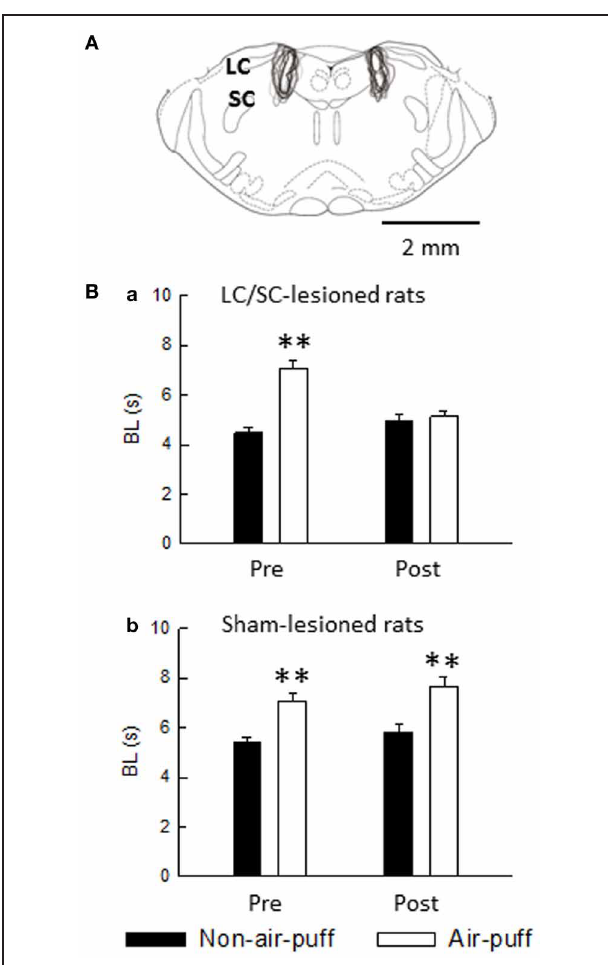
FIGURE 11 | (A) Extent of neurotoxin-induced bilateral lesions of the LC/SC ( n = 10). The rostrocaudal extension was between 0.8 and 1.5mm, and the LC/SC was always completely destroyed ventrodorsally throughout its rostrocaudal extension. The drawing is simplified from Paxinos and Watson (1998). (B) The effect of either bilateral lesions of the LC/SC ( a , n = 10) or sham lesions of the LC/SC ( b , n = 10) on the bite latency. Pre, pre-lesions; Post, post-lesions. ∗∗ P < 0 . 01, significantly different from bite latencies of the non-air-puff condition. Note that a significant air-puff stimulation-induced prolongation of the bite latency was not observed in post-lesions of the LC/SC-lesioned rats, whereas bite latencies were significantly prolonged by air-puff stimulation in pre-lesions, suggesting that the LC/SC is involved in air-puff stimulation-induced nociceptive modulation (Tsuruoka et al., 2011).